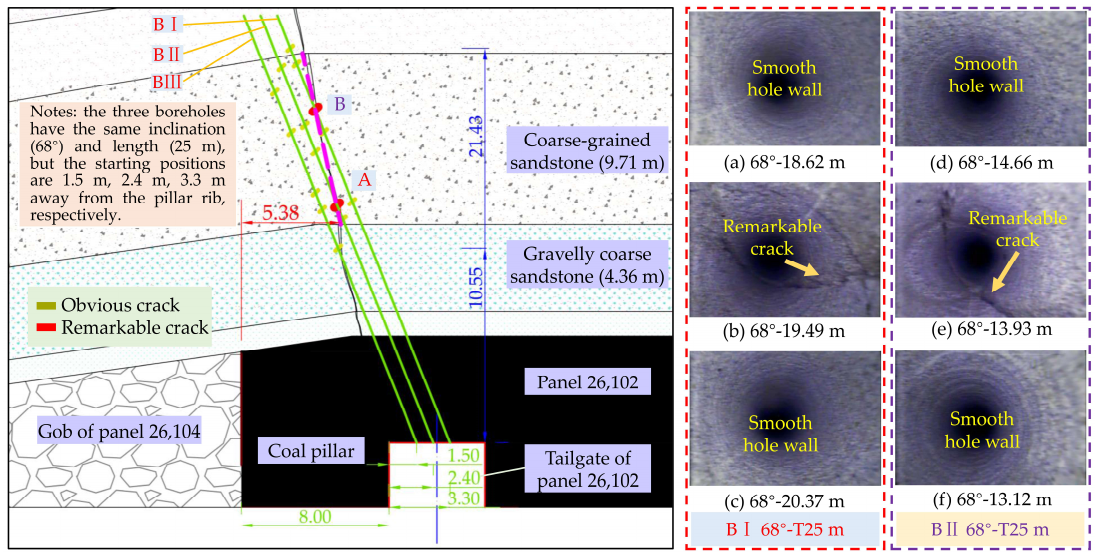
Figure 6. The distribution of roof strata cracks in 26,102 tailgate. Note: taking the representation of 45°-T35 m as an example, 45° denotes the borehole angle, and T35 m represents the full length of the borehole; taking the description of ( a ) 68°-19.62 m as an example, ( a ) denotes the serial number of the camera image of borehole, 68° denotes the borehole angle, and 19.62 m represents the detection depth.